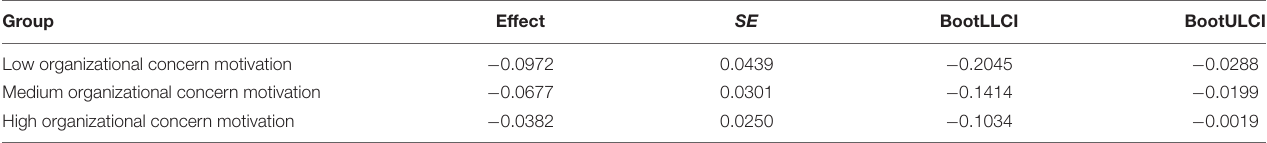
TABLE 5 | The moderated mediating effect. Group